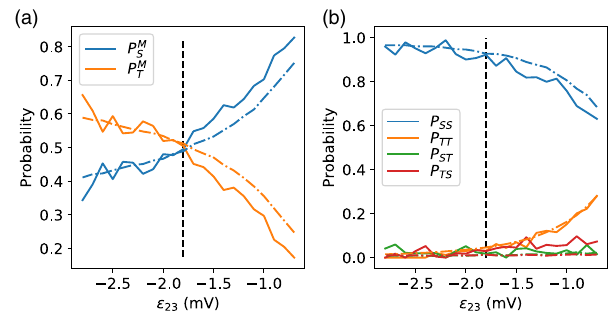
FIG. 5. Probing the low-energy singlet eigenstate of the homogeneous spin chain. (a) Singlet and triplet probability for middle-pair readout and (b) singlet-triplet correlated probabilities from left- and right-pair readout as a function of middle-pair detuning and with J 12 ¼ J 34 . Experimental data are shown as solid lines and the results from numerical simulations as dashed- dotted lines. Vertical dashed lines indicate the middle-pair detuning for which the exchange couplings are calibrated to be homogeneous. The experimentally obtained probabilities are corrected for relaxation during the readout time (see Appendix C